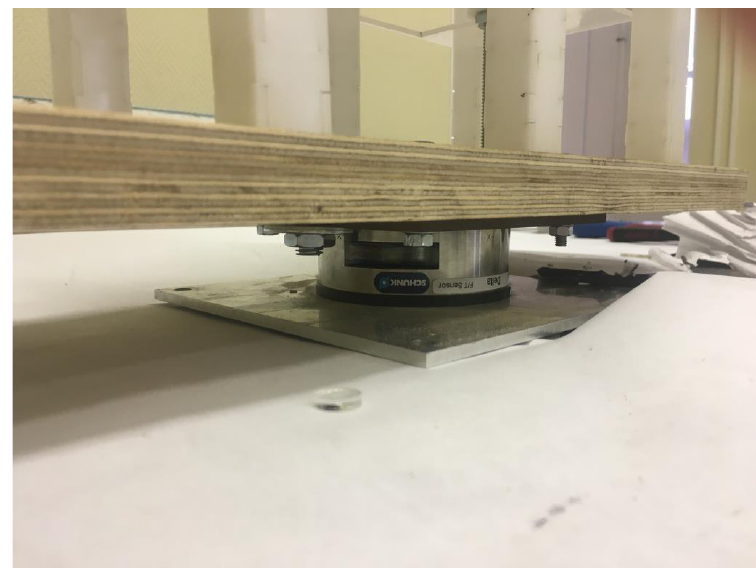
Figure 5. A 6-piece force – moment sensor at the base of the model. Force measurement range Fx, Fy: ±1 kN; Fz: ±2.5 kN; Mx, My: ±120 Nm; Mz: 120 Nm. Force measurement accuracy Fx, Fy, Fz: ±1/16 N. Torque measurement accuracy: Mx, My: ±1/160 Nm; Mz: ±1/320 Nm.